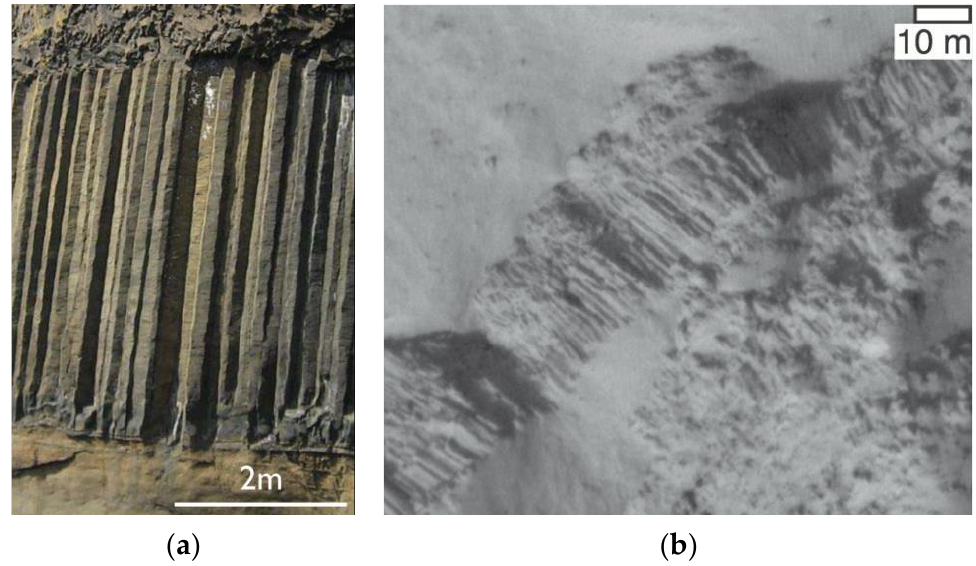
Figure 1. The columnar jointed rock masses observed in field: ( a ) Fingal’s Cave on Staffa in Scotland [6]; ( b ) the columnar joints discovered on Mars [5].